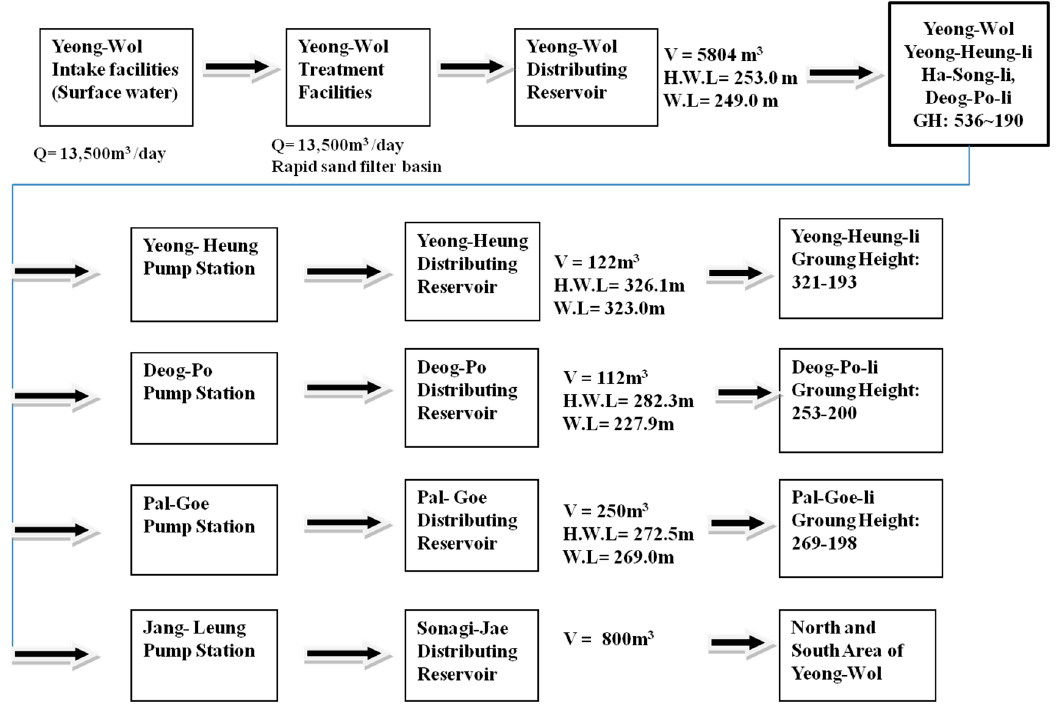
Figure 2. Water supply system diagram of Test bed (TB).